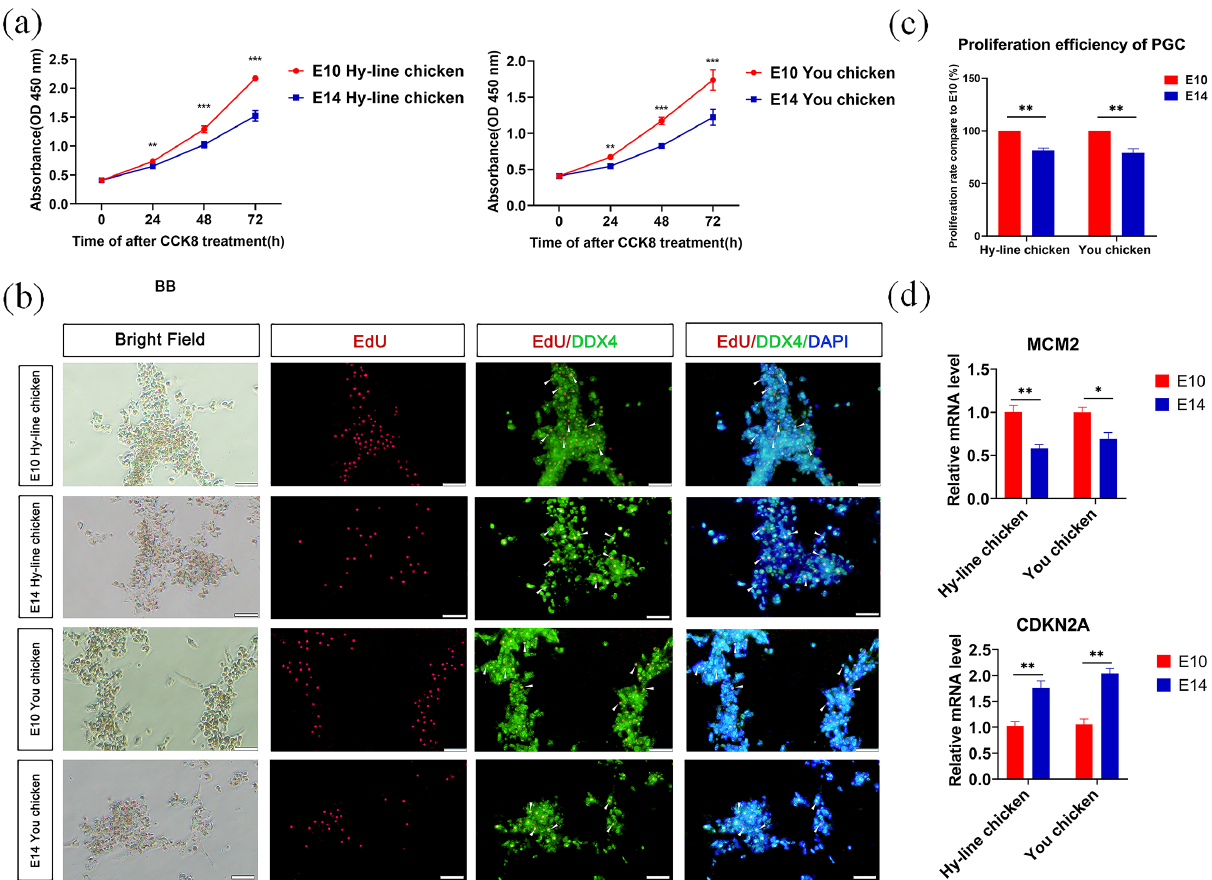
Figure 1. Comparison of the proliferation ability of E10 and E14 PGCs in both chicken breeds. ( a ) The CCK8 cell proliferation assay showed that the proliferation rate of PGCs gradually slowed down from E10 to E14 in both Hy-Line chicken (left) and You chicken (right). Data were presented as mean ± SEM, n = 5. *** p < 0.001. ( b ) Representative images of EdU staining and DDX4 immunos- taining in cultured PGCs. The arrowheads indicate EdU-DDX4 double-positive cells. ( c ) Statistical analysis of the proliferation efficiency of PGCs. ( d ) The expression of proliferation-related genes was detected by RT-qPCR. RT-qPCR was performed with the 2 − ∆∆ Ct method for analysis. Data were presented as mean ± SEM, n = 5. * p < 0.05; ** p < 0.01; *** p <